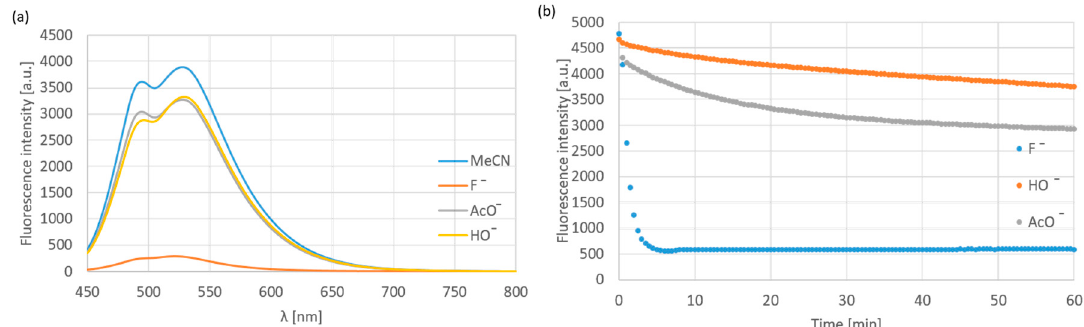
Figure 5. ( a ) fluorescence spectra obtained in the presence of 10 equivalents fluoride, acetate and hydroxy; ( b ) changes of the emission intensity during 60 min at 528 nm in the presence of the same anions.